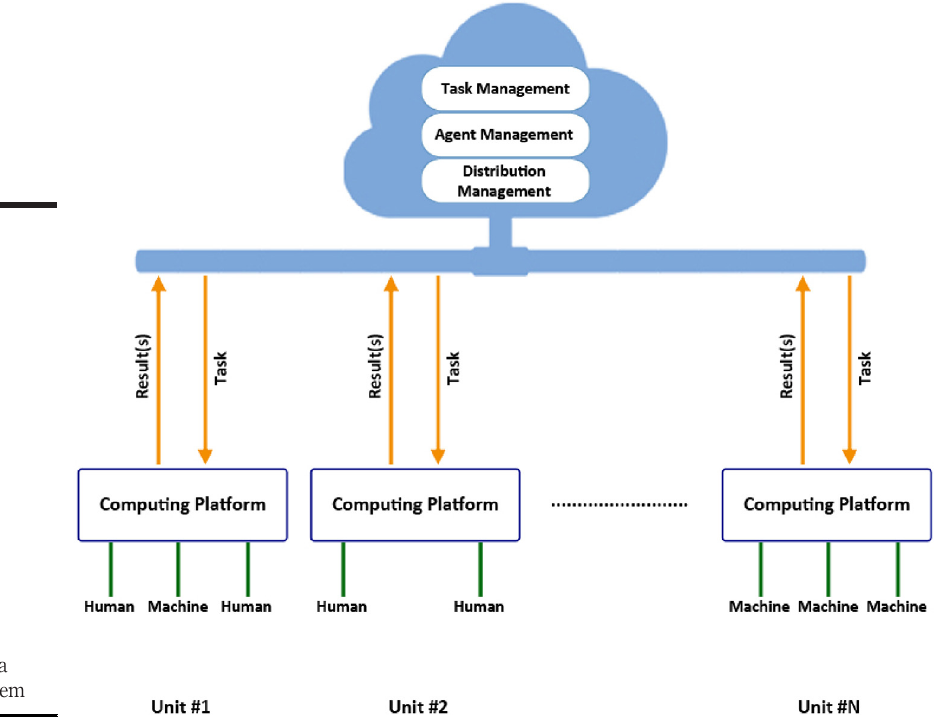
continuously updating pro fi le (list) for all the available agents and their processing and computational